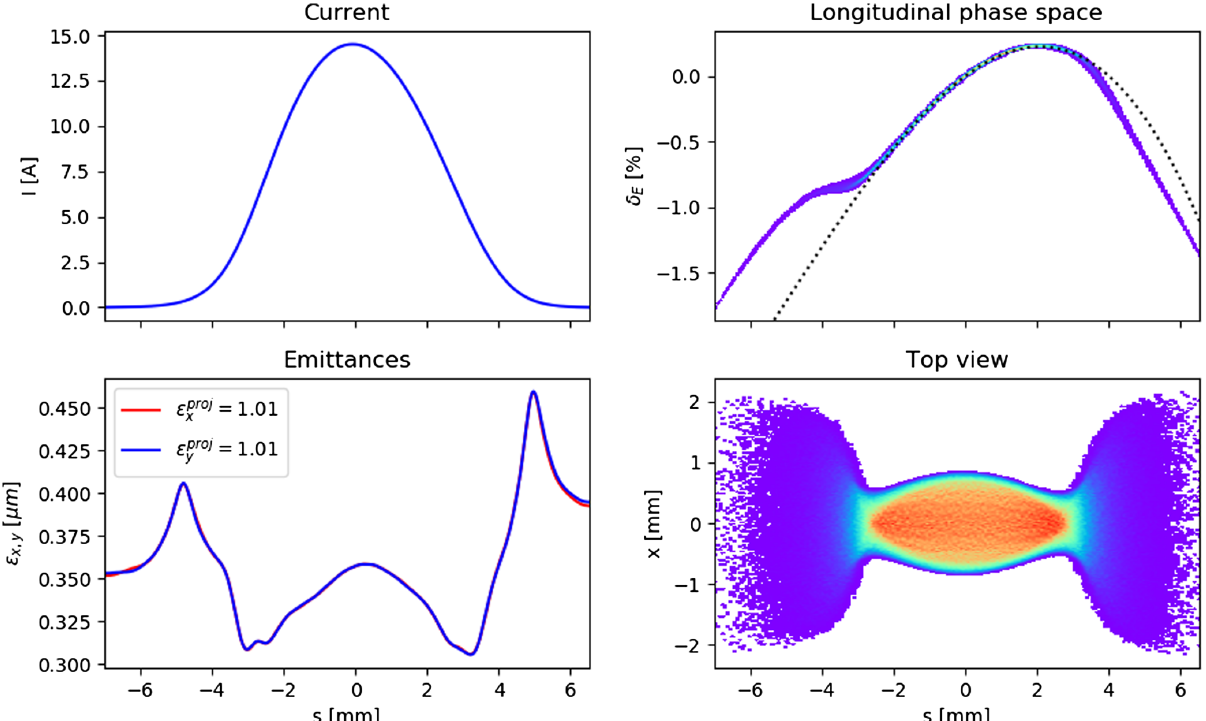
FIG. 4. The properties of the bunch with a charge of 250 pC at distance z ¼ 3 . 2 m from the cathode of the rf gun. The dotted line corresponds to Eq. (1) with coefficients from Table